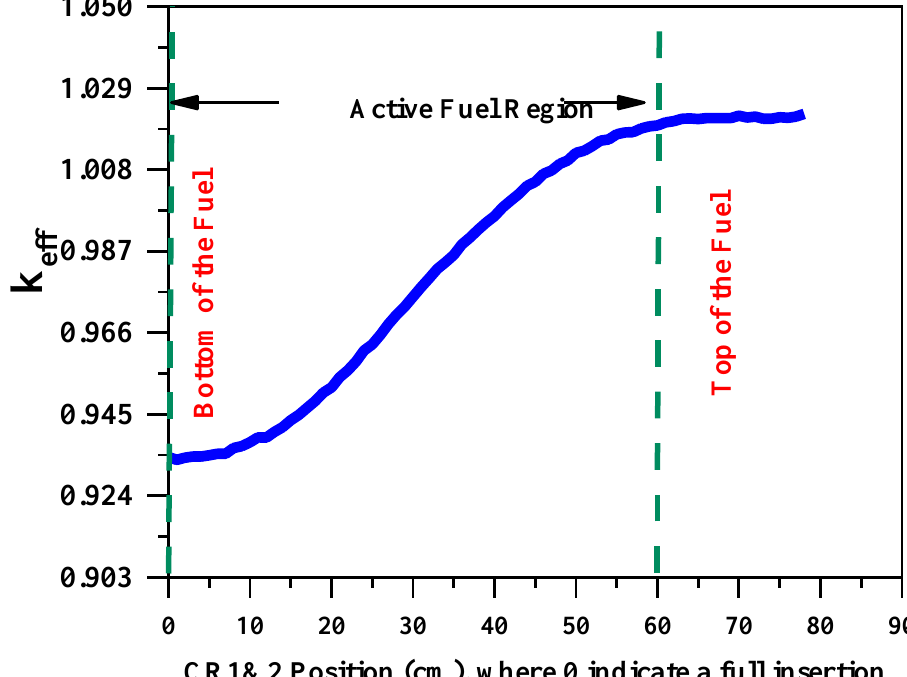
Figure 7. The worth of pair shutdown control rods (CR1 and 2).